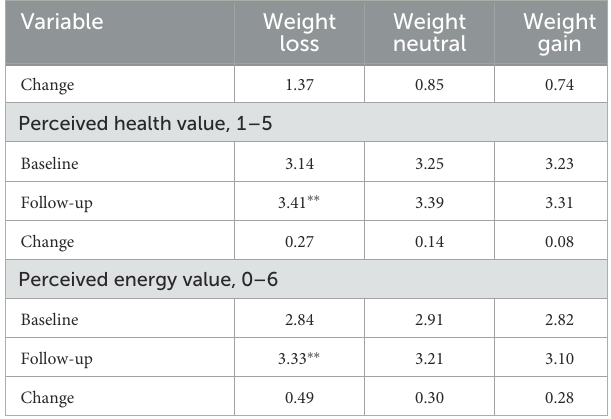
TABLE 2 Change in health measures, eating behaviors, and confidence values by weight loss